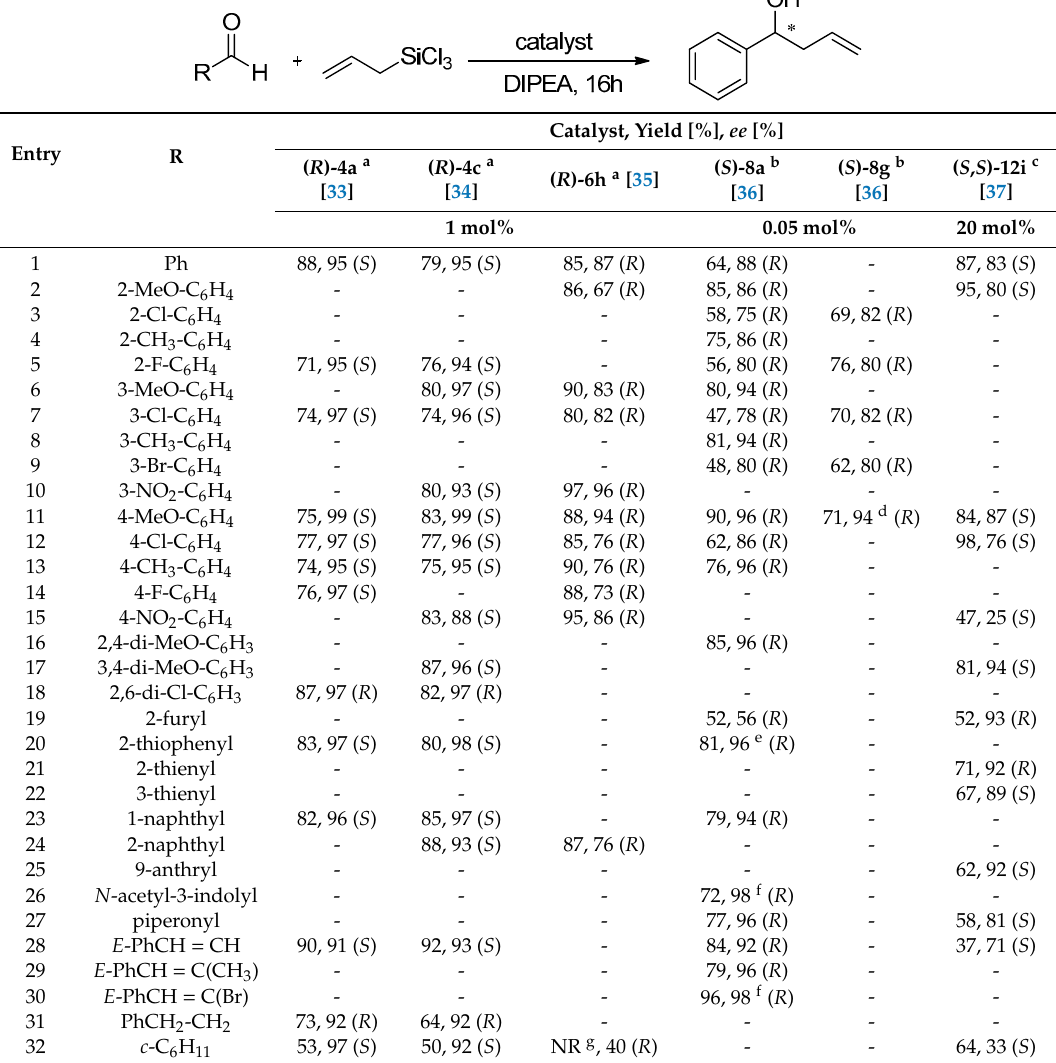
Table 1. Asymmetric allylation of aldehydes with allyltrichlorosilane catalyzed by di ff erent N -oxides.